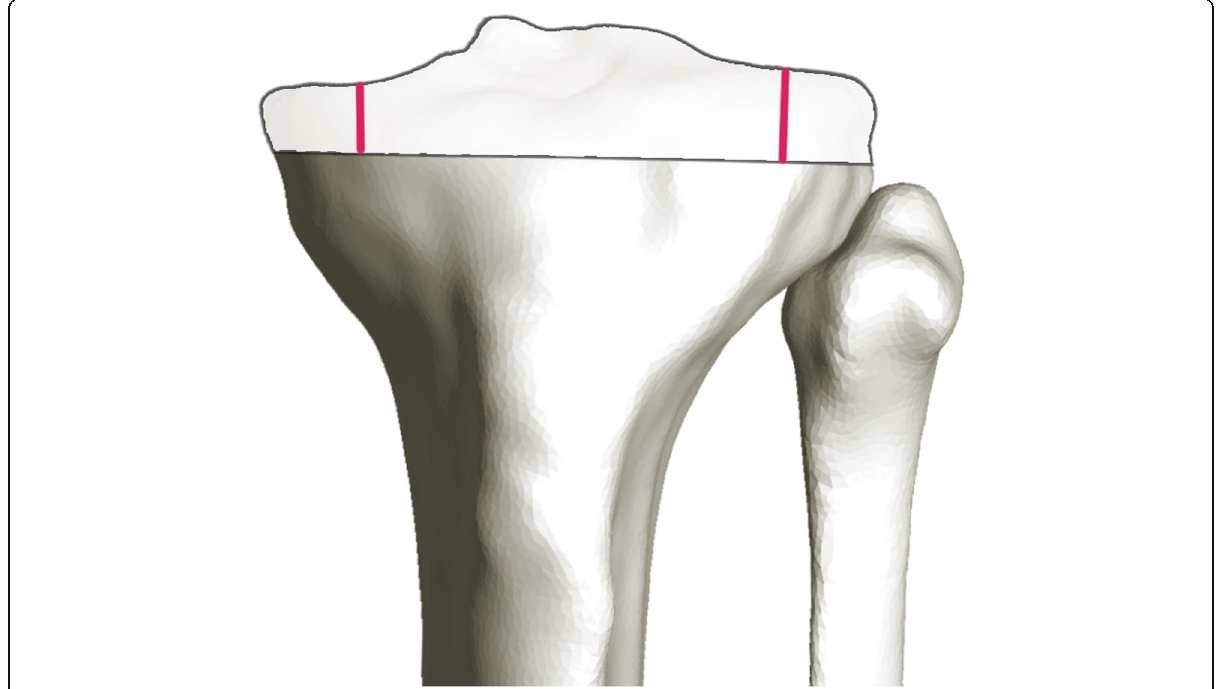
Fig. 4 Resection depth (Subject 3). [Transparent anatomy is the MRI surface model; opaque anatomy is the resected CT surface